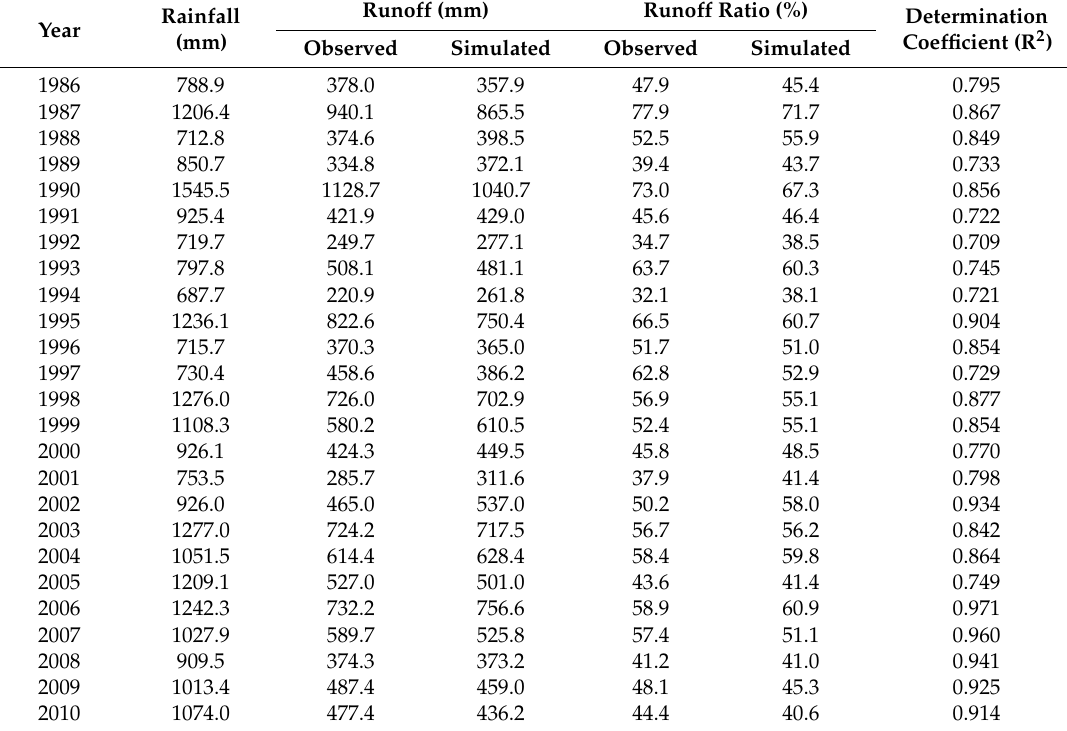
Table 3. Runoff ratio and Determination coefficient.